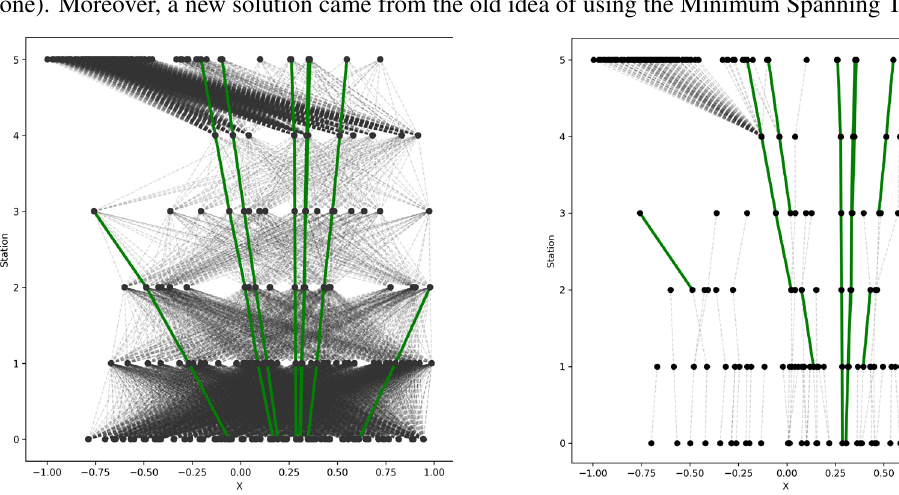
Figure 1. (Color online) The event-as-a-graph rep- resentation of the C + C 4GeV simulated BM@N experiment event. Dots are the hits, lines are the track-candidate segments.